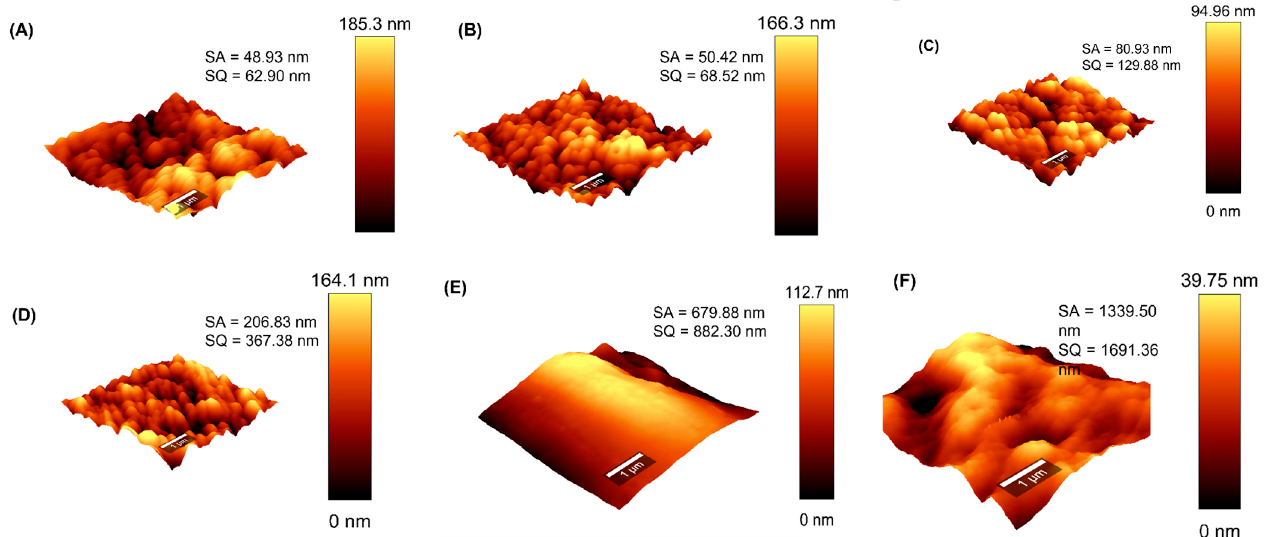
Figure 3. Topographical micrographs displaying surface roughness of ( A ) M1, ( B ) M2, ( C ) M3, ( D ) M4, ( E ) PTFE-20, and ( F )